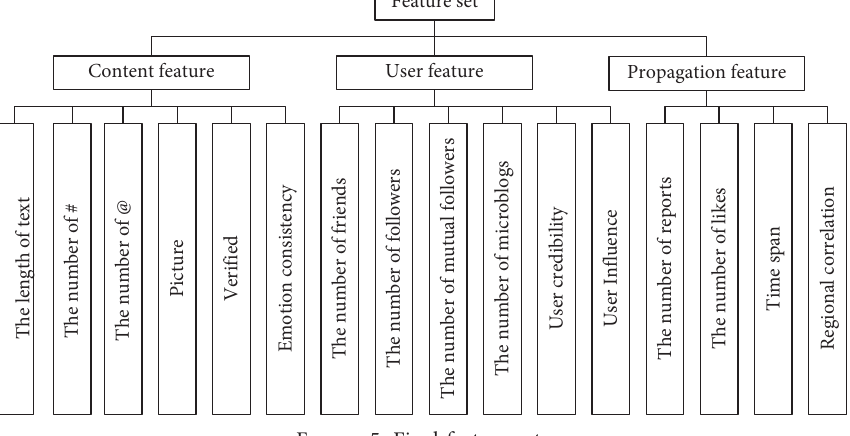
Figure 5: Final feature